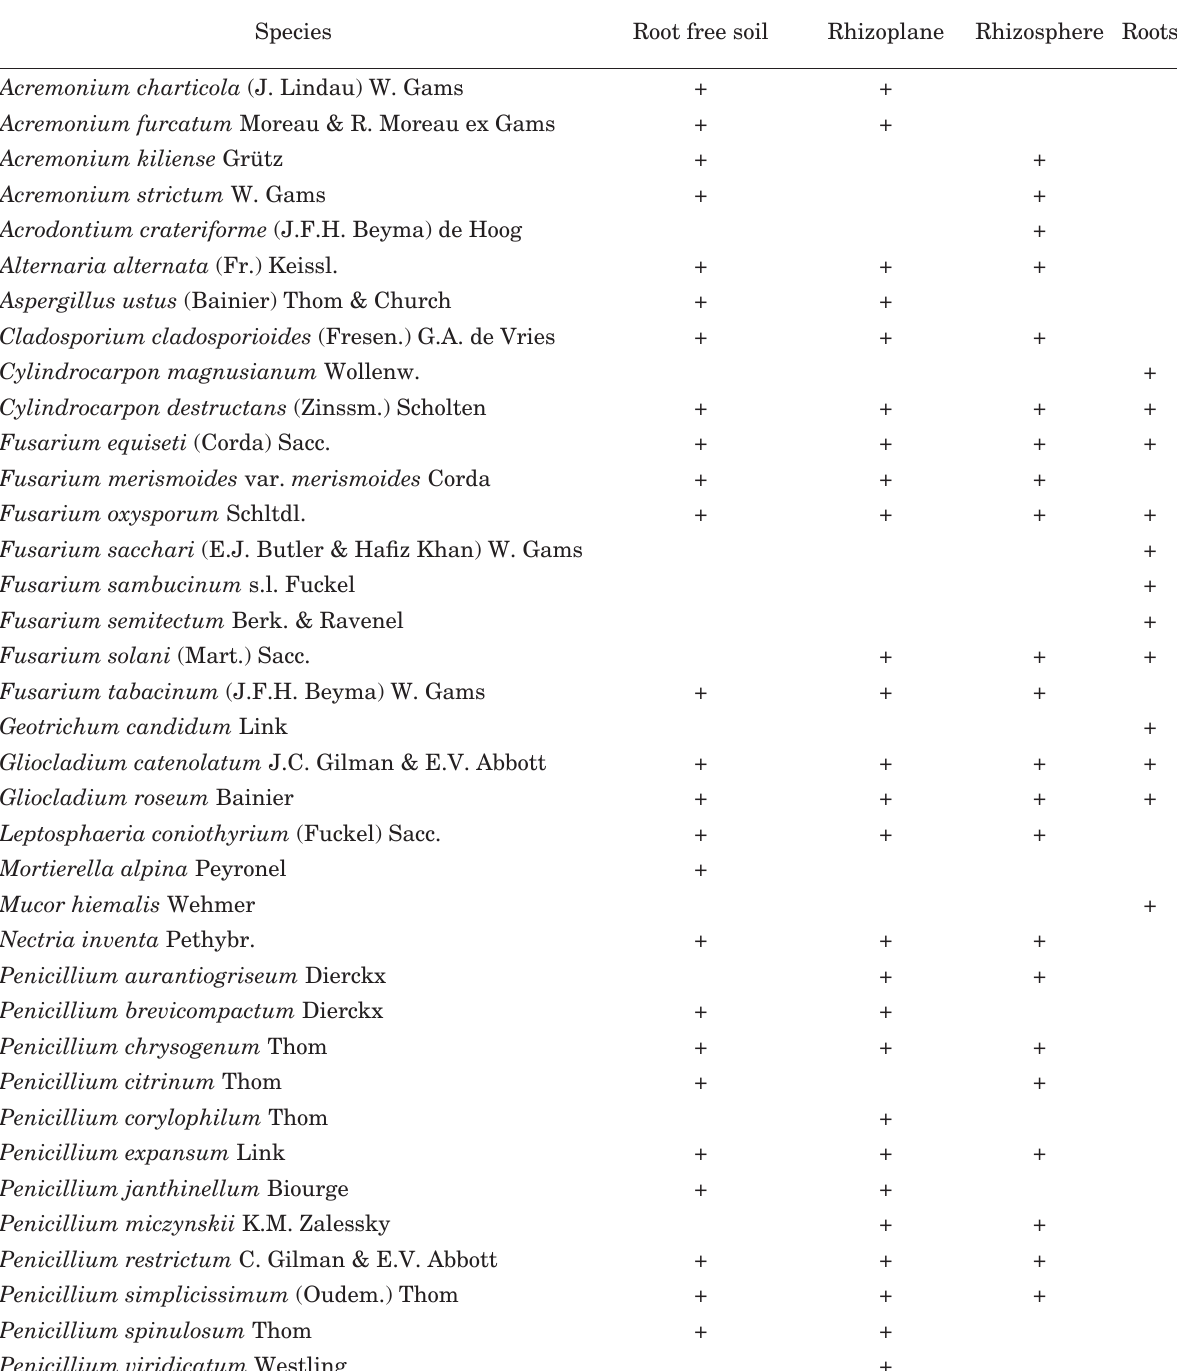
Table 1. Fungi isolated from a trial vineyard in Kiedrich (Germany) used to test the speci fi city of the designed primers.